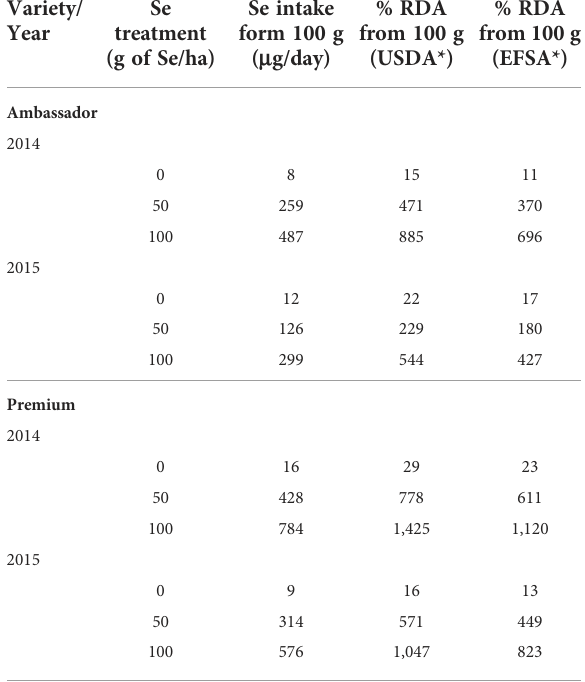
TABLE 5 Selenium intake and percentage of recommended dietary allowance for Se (% RDA) covered by 100 g of pea seeds. Variety/ Se Year